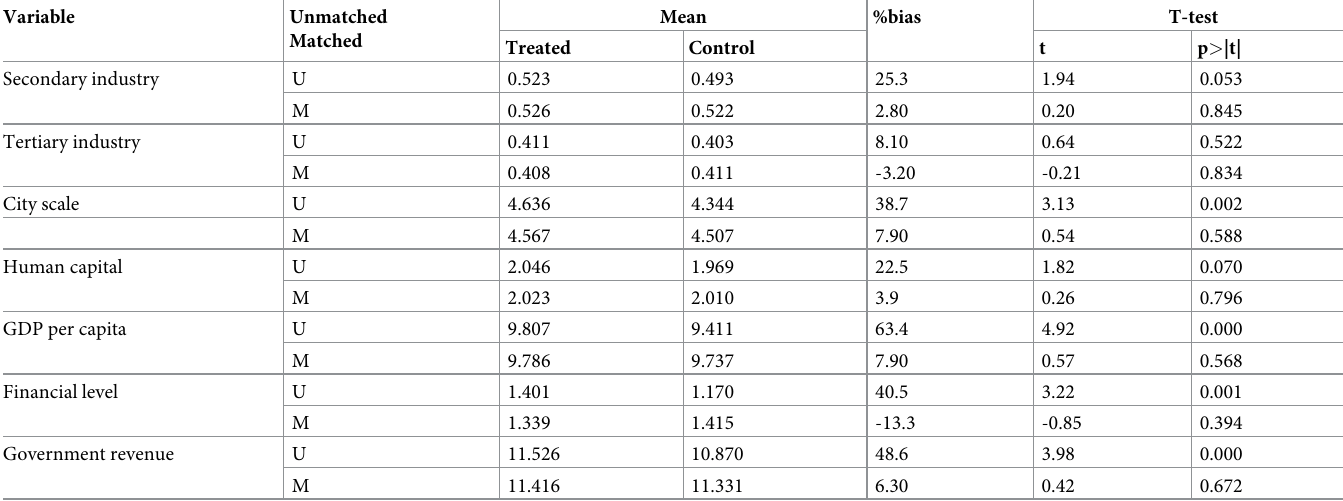
Table 3. PSM balance test results in 2003.